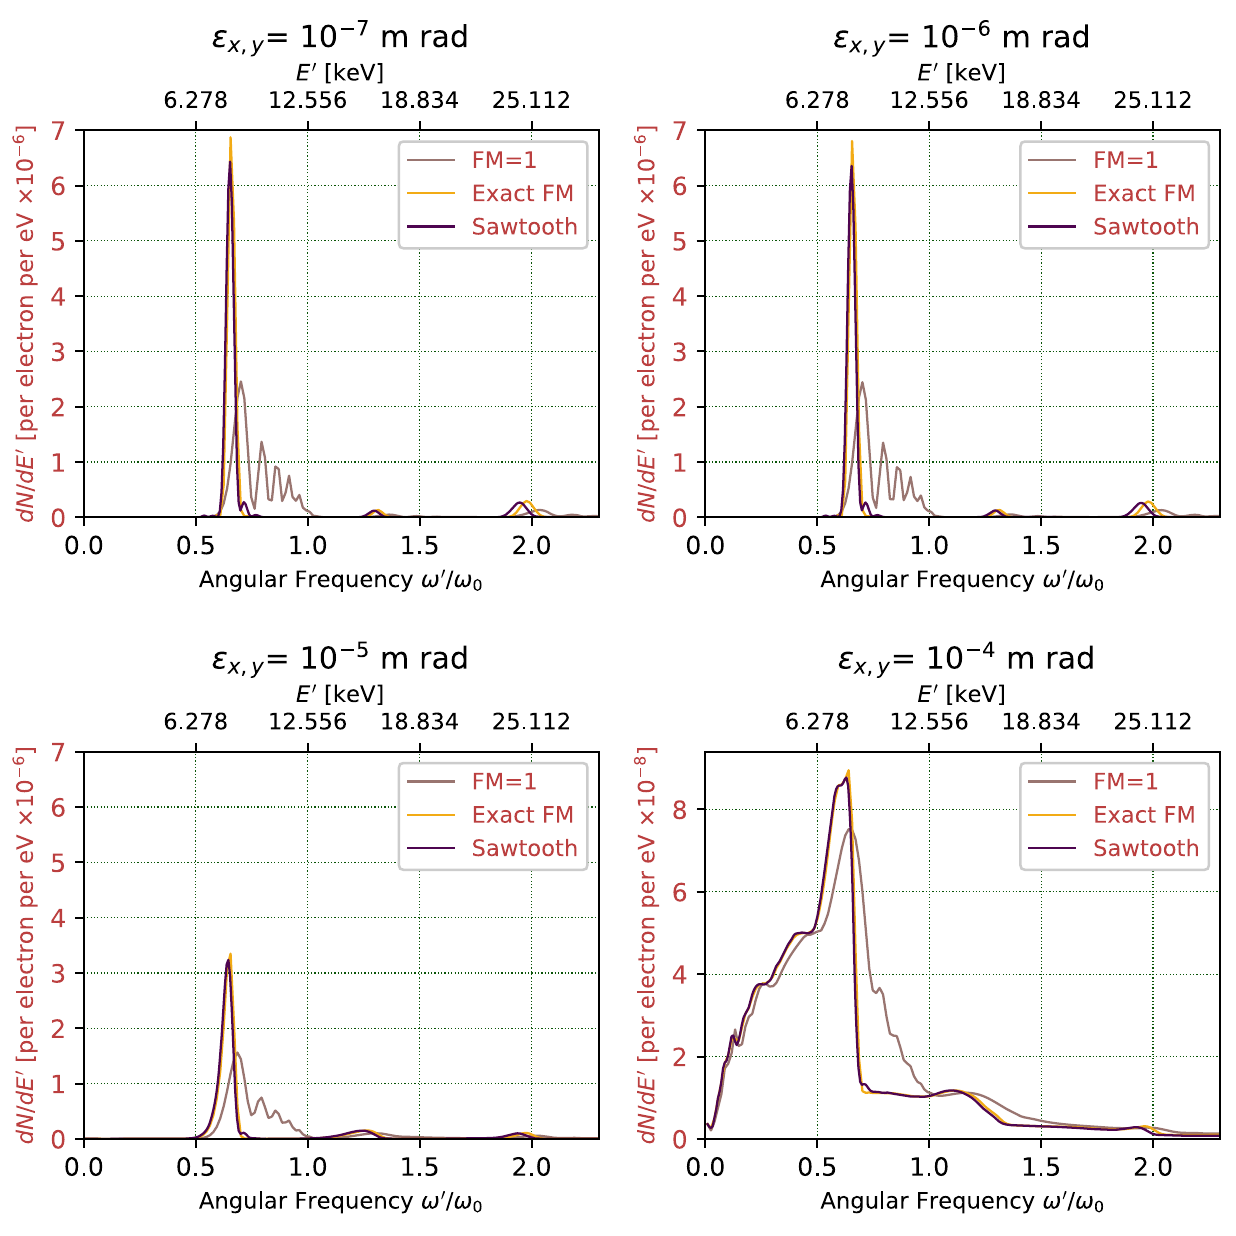
FIG. 8. Comparison of simulated spectra with three different FM functions: uncorrected simulation (FM ¼ 1 ), the optimal chirping solution [11], and a sawtooth chirping function. The simulations were conducted for a range of normalized circular emittance ϵ x ¼ ϵ y values. In the case of the most extreme emittance (bottom right panel), the spectra have been rescaled by two orders of magnitude on the right vertical axis. The following parameters were used in the simulations: E e ¼ 23 MeV; Δ E e =E e ¼ 0 . 175% ; σ x ¼ 41 μ m; σ ¼ 81 μ m; a ¼ 1 . 5 ; λ ¼ 800 nm; σ ¼ σ ¼ 13 . 59 μ m; σ ¼ 5 . 57 . Note that the scale of the y-axis is fixed for the top two y 0 x;l y;l plots and the lower left plot, but the scaling on the bottom right plot has been adjusted since the peaks are two orders of magnitude smaller than the other